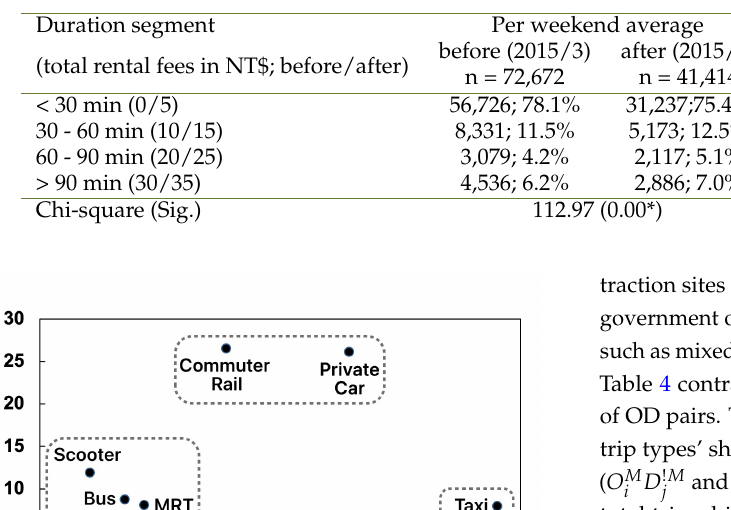
Table 3. Table 3. Daily trip share by the rental duration